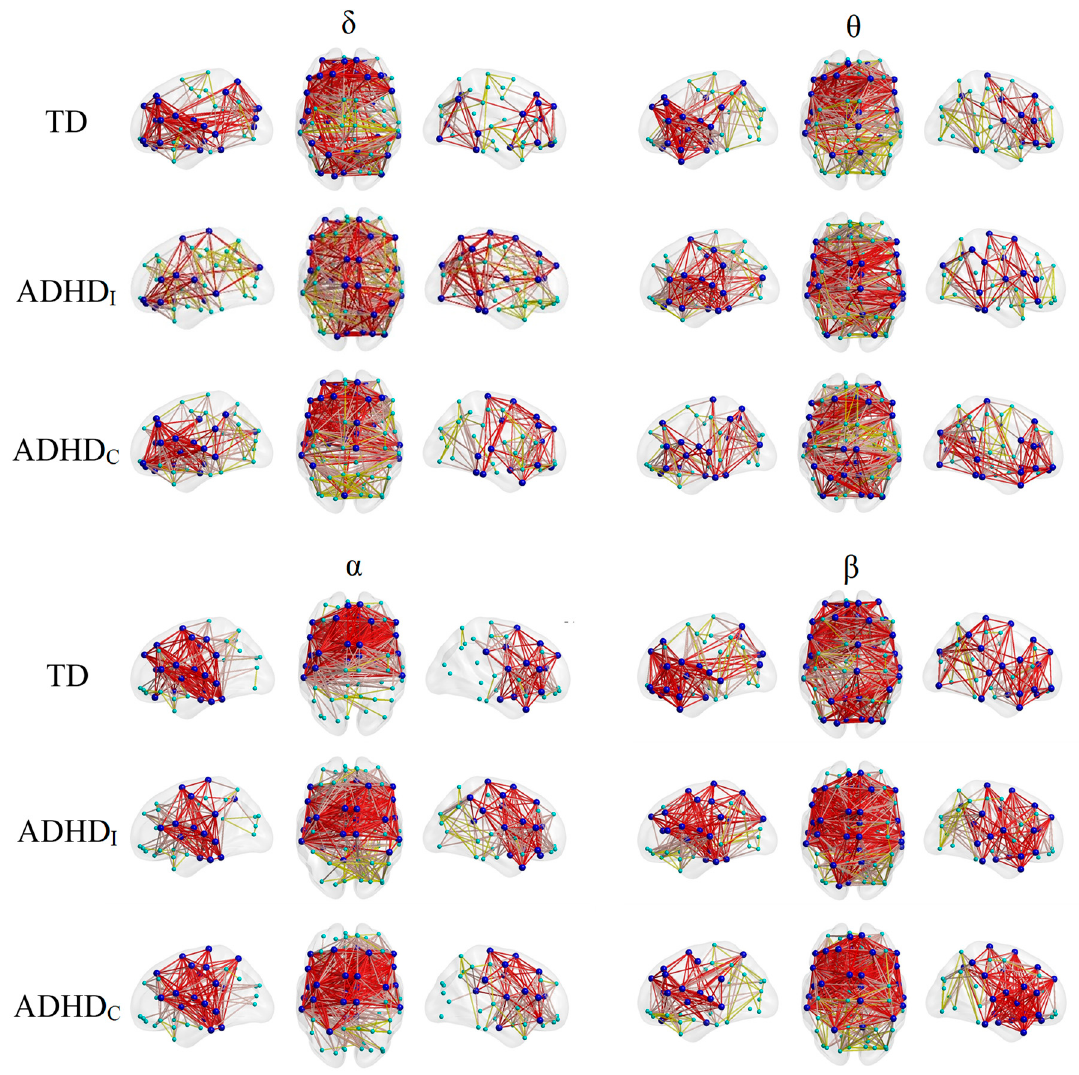
Figure 4. Lateral and axial views of the rich-club node (blue) distributions and connections (red edges) for each group in each frequency band. The feeder and local connections are shown in orange and yellow, respectively. Local nodes are shown in green. Nodes represent the centroids of the AAL regions.